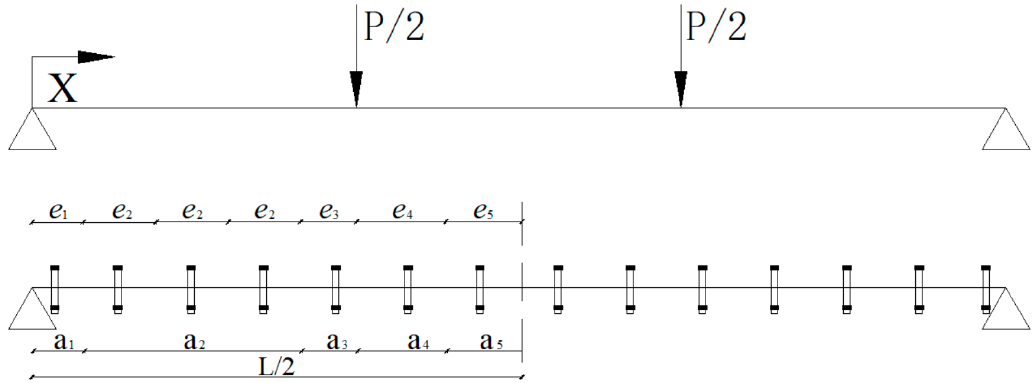
Figure 8. Calculation diagram and bolt arrangement under three-point loading.